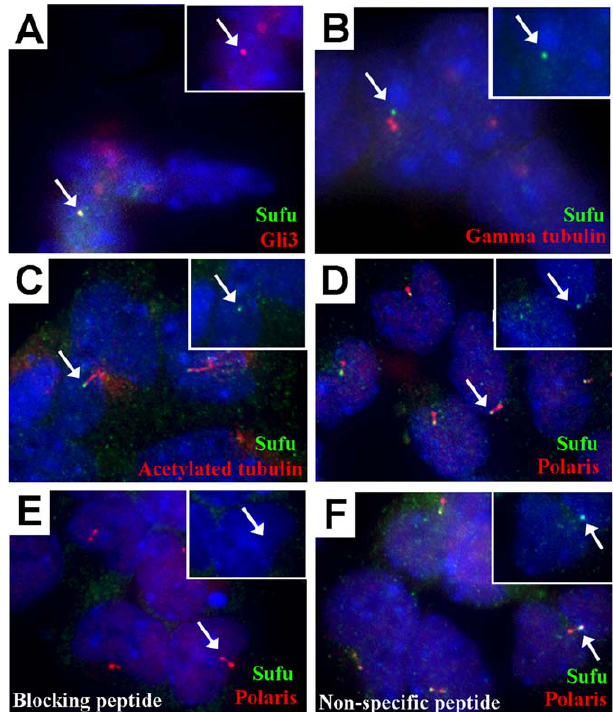
Figure 6. Endogenous Sufu and Gli3 Localize to the Distal Tip of the Cilium in Wild-Type Primary Limb Cell Cultures Sufu (green) and endogenous Gli3 (red) concentrate in the same domain in cultured wild-type limb bud cells (A). As shown for the full-length Gli::GFP proteins, endogenous Sufu does not colocalize with c -tubulin (red) (B), but is concentrated in a domain at the distal end of the acetylated a -tubulin staining (red) (C). Sufu also partially overlaps with a domain of Polaris (red) (D) in cultured wild-type limb bud cells. Pre- incubation of anti-Sufu antiserum with the immunizing peptide (E), but not with a nonspecific peptide (F), blocks staining at the distal tip of the cilium (anti-Polaris, red; anti-Sufu, green). Inset in all panels shows Gli3 (A) or Sufu (B–F) staining only in the indicated cilium (arrow). DOI: